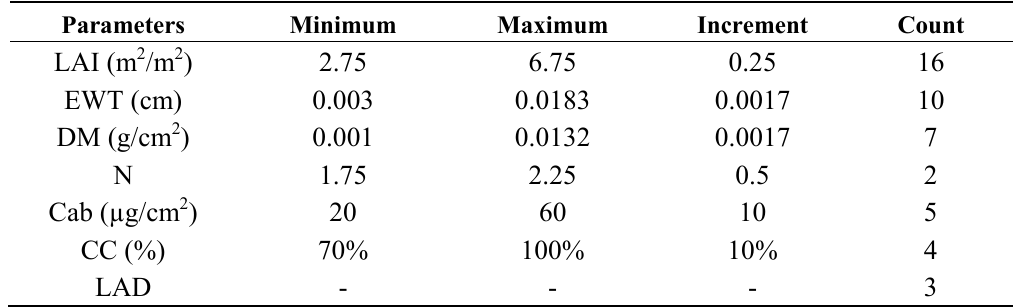
Table 1. Parameters, their ranges and increments for the final simulation. The final column shows the total number of values used for each parameter. The parameters are leaf area index (LAI), leaf equivalent water thickness (EWT), leaf dry matter content (DM), leaf structural parameter (N), leaf chlorophyll a + b concentration (Cab), canopy cover (CC) and leaf angle distribution (LAD). The three LADs used were planophile, plagiophile, and